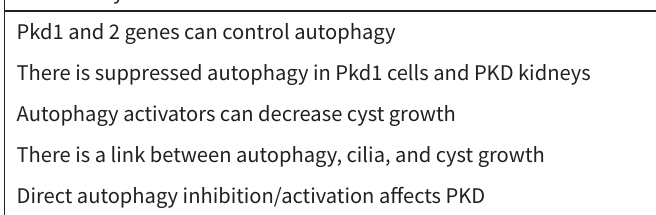
Table 2. Reasons to Suspect That Suppressed Autophagy May Play a Role in Cyst Growth in ADPKD Pkd1 and 2 genes can control autophagy There is suppressed autophagy in Pkd1 cells and PKD kidneys Autophagy activators can decrease cyst growth There is a link between autophagy, cilia, and cyst growth Direct autophagy inhib ition /acti vatio n affects